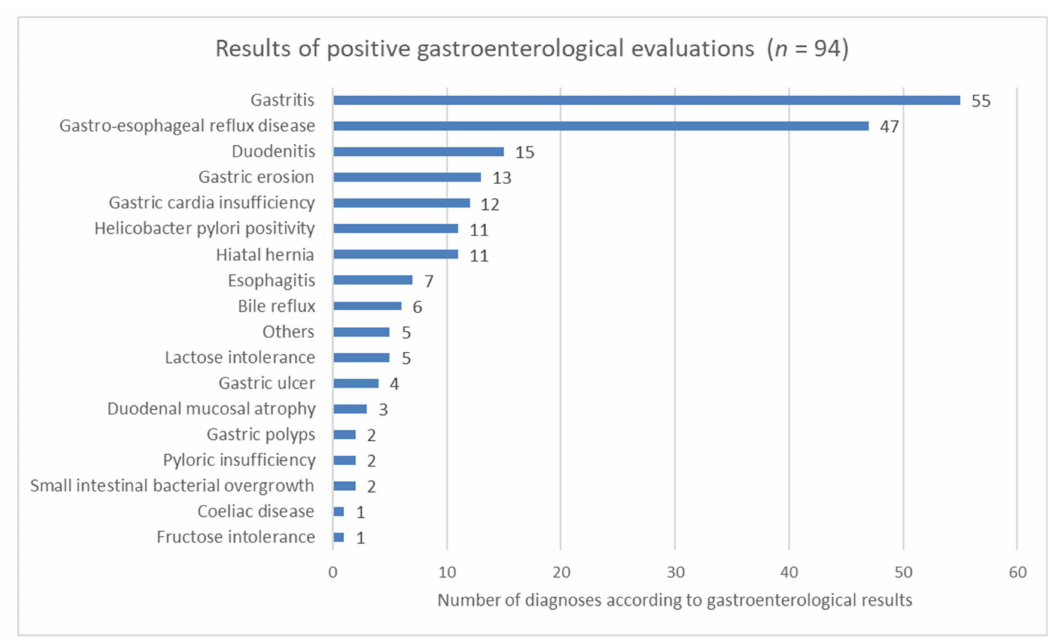
Figure 3. Results of positive gastroenterological examinations initiated as a result of the food-related complaints of